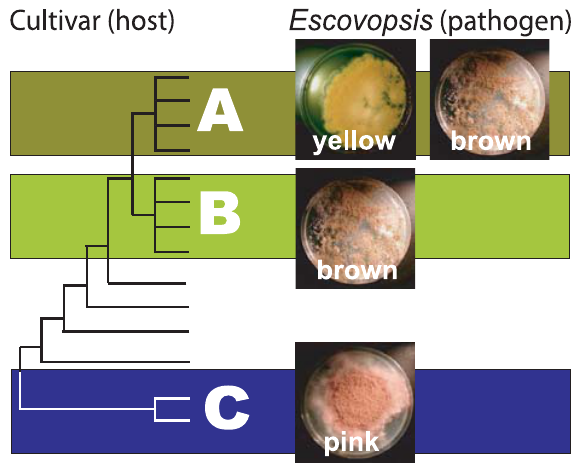
Figure 1. Schematic Diagram of the Escovopsis –Cultivar System Fungus-growing ants in the genus Apterostigma cultivate fungi in three distinct groups. Cultivars in clade C (referred to in the text as cultivar C) are lepiotaceous fungi distantly related to the pterulaceous cultivars in clades A and B. Free-living, nonsymbiotic fungi fall between clade C and the other cultivars. Each cultivar clade is attacked by specific Escovopsis types, here identified according to spore color. Note that the same brown Escovopsis attacks both cultivars A and B. Schematic cultivar phylogeny based on [33]. DOI: